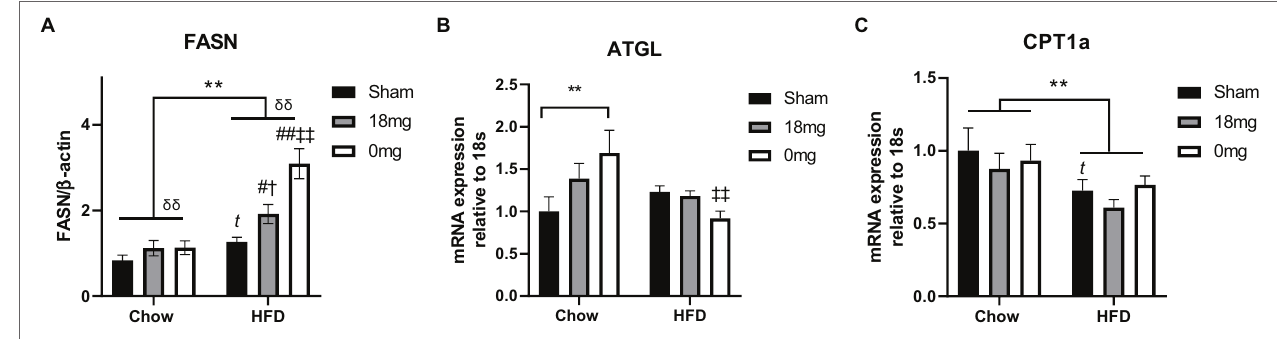
FIGURE 1 | Lipid metabolic markers in the liver. Protein level of FASN (A) , mRNA expression of ATGL (B) and CPT1a (C) in mice fed a HFD with or without the exposure to e-vapour. The results are expressed as mean ± SEM, n = 5–8. Data were analysed by two-way ANOVA followed by Fisher’s least significant difference (LSD) post-hoc tests. A conditional t -test for non-overlap of value distributions was performed between the control (Chow + sham or HFD + sham) and interventional groups. ** p < 0.01 diet effect, δδ p < 0.01 e-vapour exposure effect; tp < 0.05 vs. Chow + Sham by conditional t -test, # p < 0.05, ## p < 0.01 vs. HFD + Sham, † p < 0.05 vs. Chow + e-cig18mg and ‡‡ p < 0.01 vs. Chow + e-cig0. ATGL, adipose triglyceride lipase; CPT, carnitine palmitoyltransferase; and FASN, fatty acid